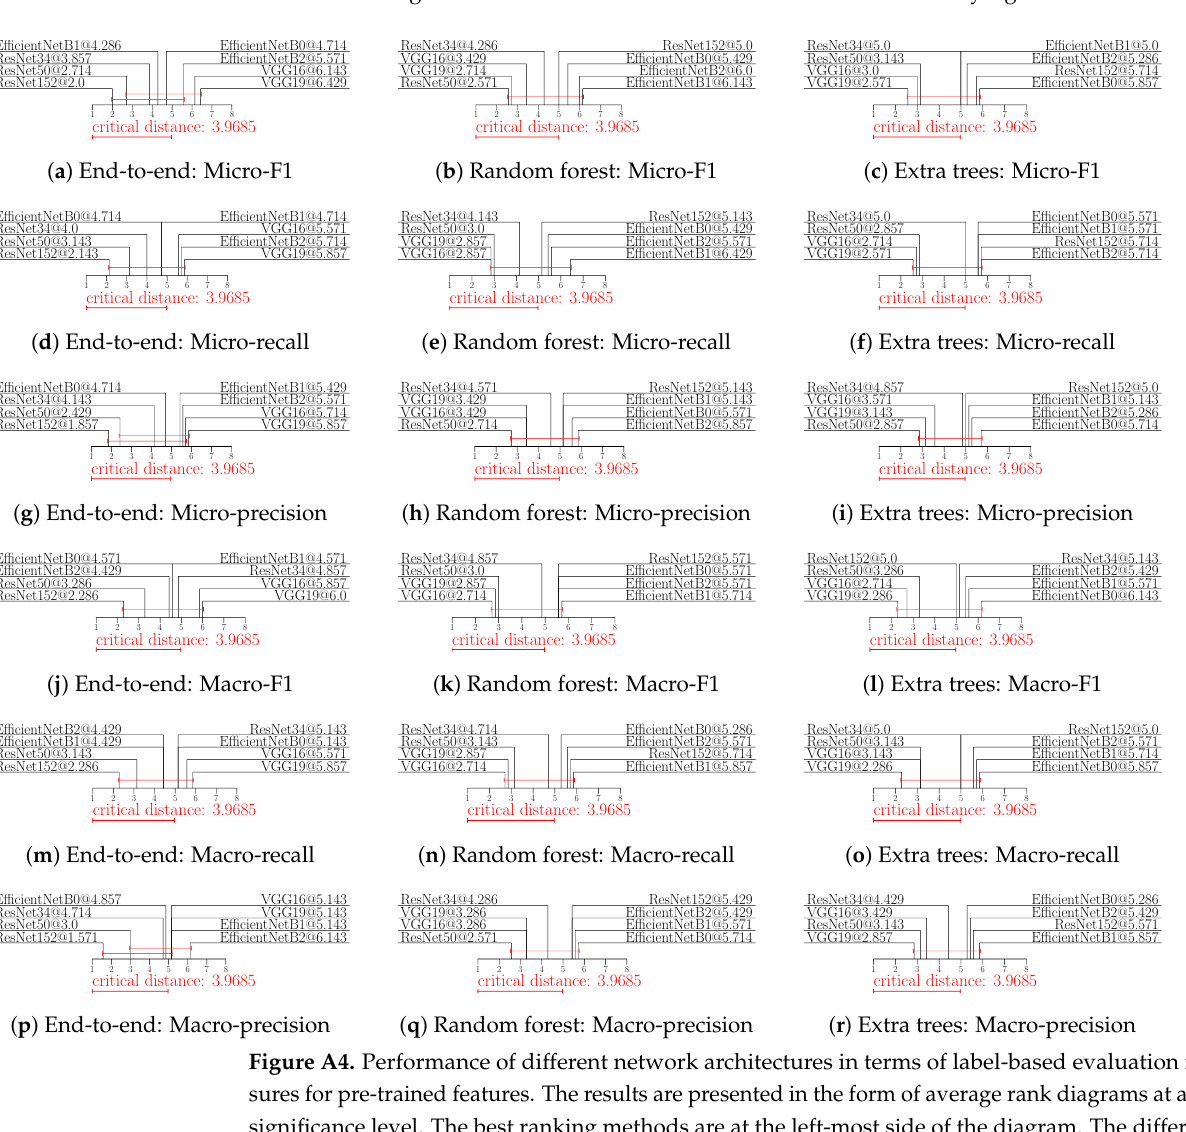
Figure A3. Performance of different network architectures in terms of ranking-based evaluation measures for fine-tuned features. The results are presented in the form of average rank diagrams at a 0.05 significance level. The best ranking methods are at the left-most side of the diagram. The difference among the methods connected with a red line is not statistically significant.